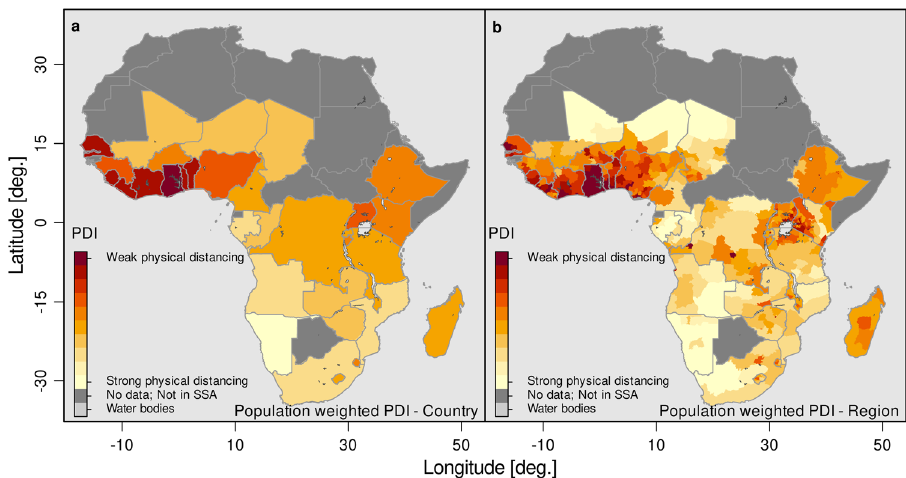
Fig. 1 PDI at country and regional level. Country ( a ) and regional ( b ) level PDI. The panel depicts the capabilities of households to follow social distancing measures based on a simple multidimensional measure calculated based on (1) number of households sharing toilet facilities, (2) usage of public water source, (3) persons per room, (4) no access to ICT, (5) bicycle or other vehicle is not present, based on a PCA. The estimates are normalized between zero and one. Source: DHS and Center for International Earth Science Information Network — CIESIN — Columbia University 52 ; calculations by the